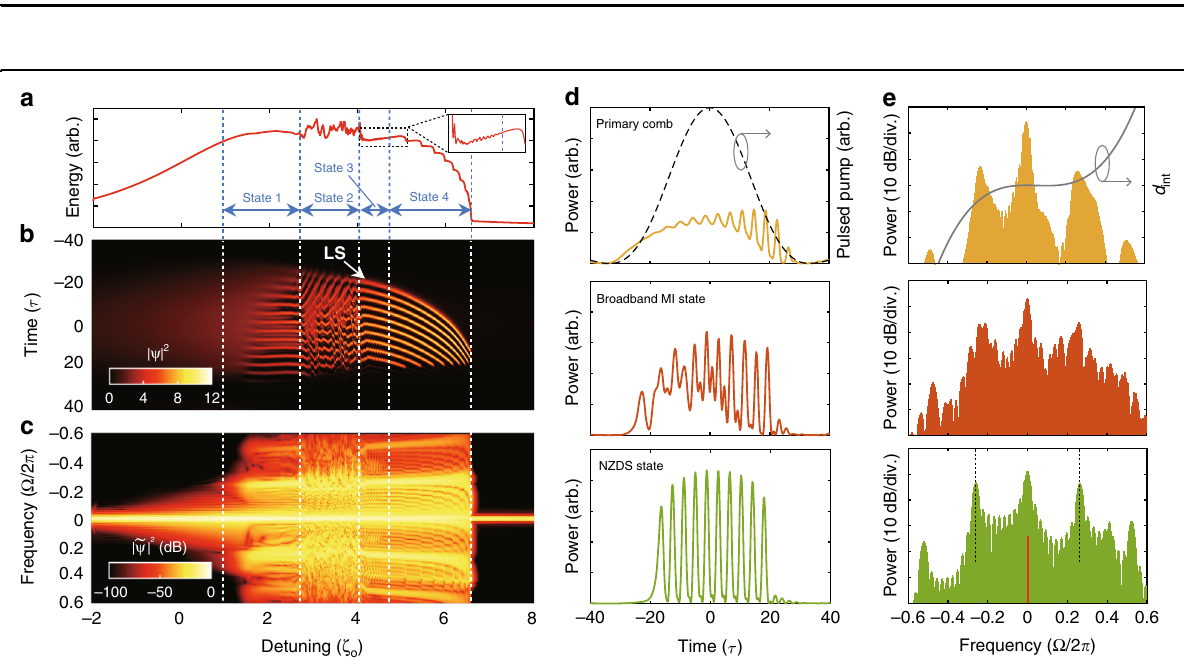
Fig. 2 Simulation of anomalous-dispersion based near-zero-dispersion soliton via desynchronized pulse pumping. a Intracavity power, b temporal and c spectral evolution of near-zero-dispersion soliton with increased detuning. States 1 to 4 correspond to the primary comb, broadband MI, unstable NZDS and NZDS states. Inset in a shows a zoomed view of unstable NZDS power fl uctuation. The white arrow in b marks the position of leading soliton (LS). d Temporal waveforms and e spectral pro fi les of primary comb state ( ζ 0 = 1.6), broadband MI state ( ζ 0 = 3.2), and NZDS state ( ζ 0 = 4.8). In the NZDS state, the black-dashed lines mark the position of two prominent combs near the pump denoted by the red line. The gray dashed line in ( d ) plots the pulsed pump envelope. The gray solid line in ( e ) depicts the normalized d int curve for d 2 = − 1, d 3 = 1 = − 1, TOD set as − 2.4, which introduces a proper counter-acting strong TOD (considering GVD parameter d 2 = 1). The normalized d group-velocity shift and helps to maintain the soliton parameter d pro fi les see gray 3 int = d Ω 2 + d Ω 3 ( Ω is the nor- structure. The drift coef fi cient d is de fi ned as the nor- line in Fig. 2e, where d int 2 3 malized group-velocity difference between the intracavity malized angular frequency, and the details of all para- fi elds and the pulsed pump (details in “ Materials and meter normalization can be referred to “ Materials and Methods ” ). The pulsed pump is composed of total Methods ” ). Under the in fl uence of TOD, it breaks the M + 1 = 51 spectral lines with equal phase and power, symmetry in the temporal and spectral pro fi les, which and its normalized peak power F is set as 12. The wave- leads to a constant-velocity temporal drift 33 . To com- form pro fi le of the driving pulse is plotted in the gray pensate this group-velocity shift, the drift coef fi cient d is